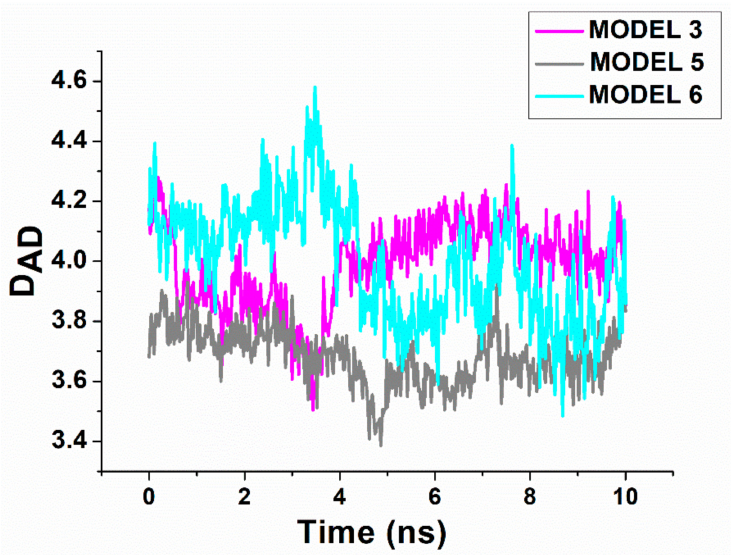
Figure 5. Temporal evolution of the D DA distance between the 5 (cid:48) end of miR-155 and the aromatic ring center of the lateral chain of Trp214, for Model 3 and Model 5 of the complex during a MD